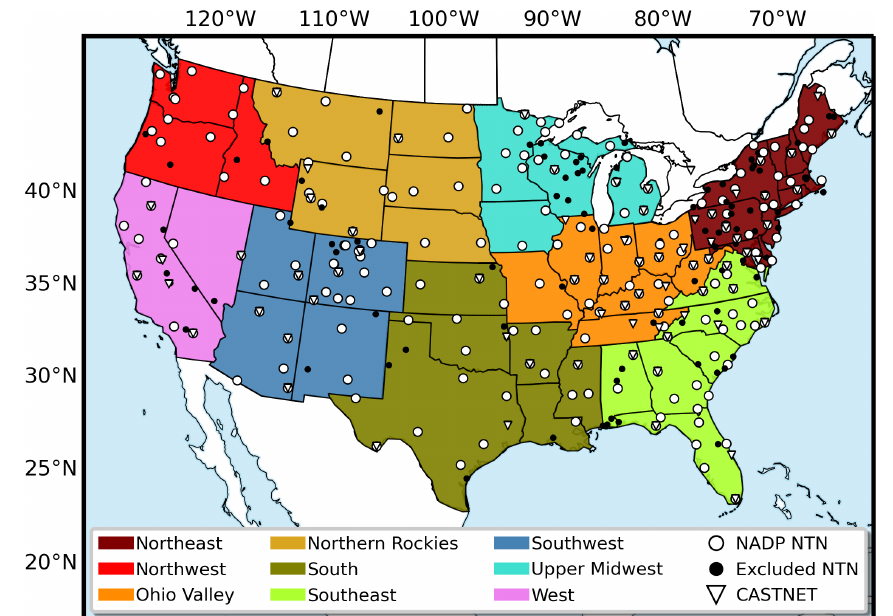
Figure 1. Locations of the 200 National Atmospheric Deposition Program (NADP) National Trends Network (NTN, white circles) and 75 Clean Air Status and Trends Network (CASTNET, triangles) sites examined in this study. NADP NTN sites shown in black circles did not meet completeness criteria thresholds and therefore were not included in this analysis. Color-coded US climate regions shown in this map are referred to throughout this analysis. The black-bordered white circles indicate NADP NTN sites that meet annual completeness criteria for 13 years of the time series and are examined in the model evaluation presented in Sect.